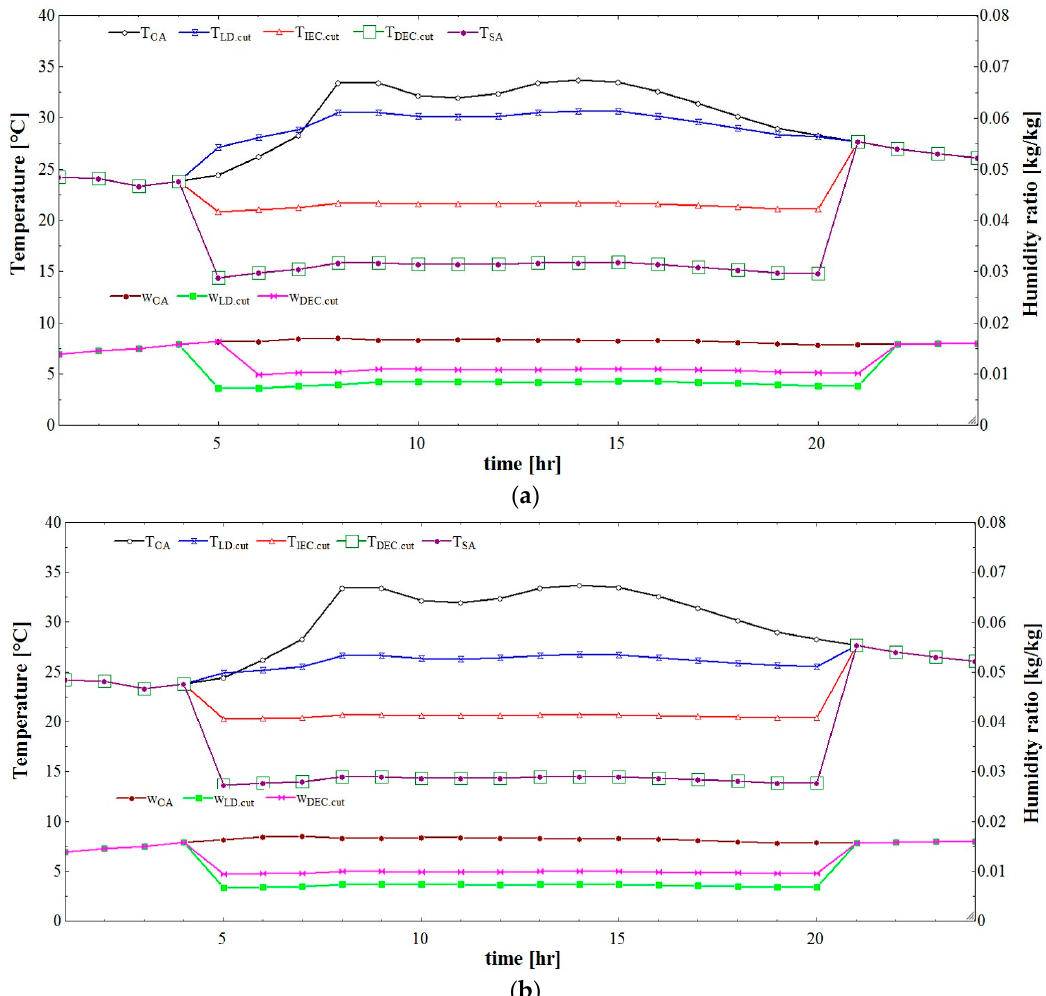
Figure 7. Thermal behavior of the systems on the peak cooling day. ( a ) Conventional LD-IDECOAS; ( b ) HPLD-IDECOAS.